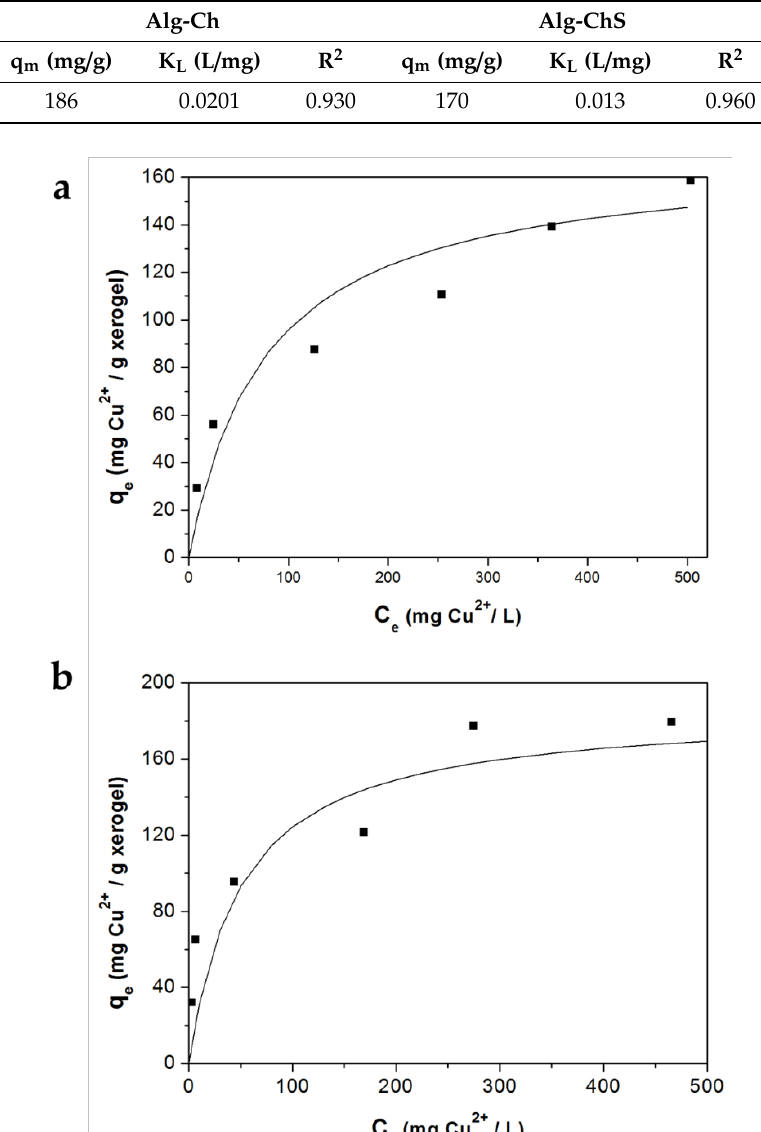
Figure 5. Cu(II) adsorption isotherms at the initial pH of 5.0 using ( a ) Alg-ChS hydrogel beads, ( b ) Alg-Ch beads. Experimental data ( (cid:4) ) and Langmuir model